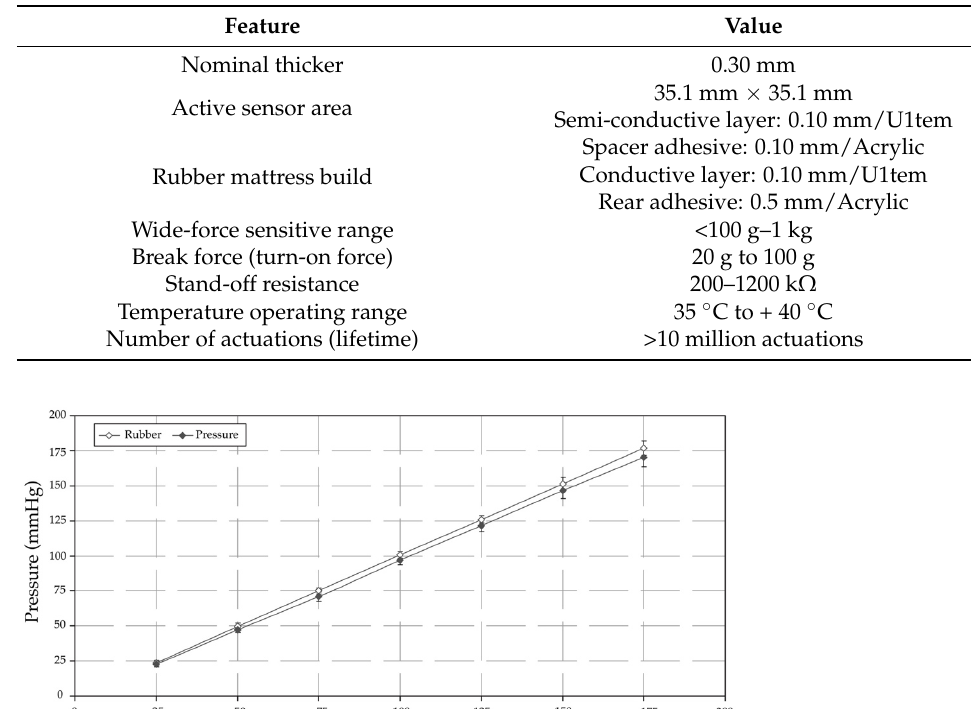
Table 6. Conductive force-sensitive resistor.